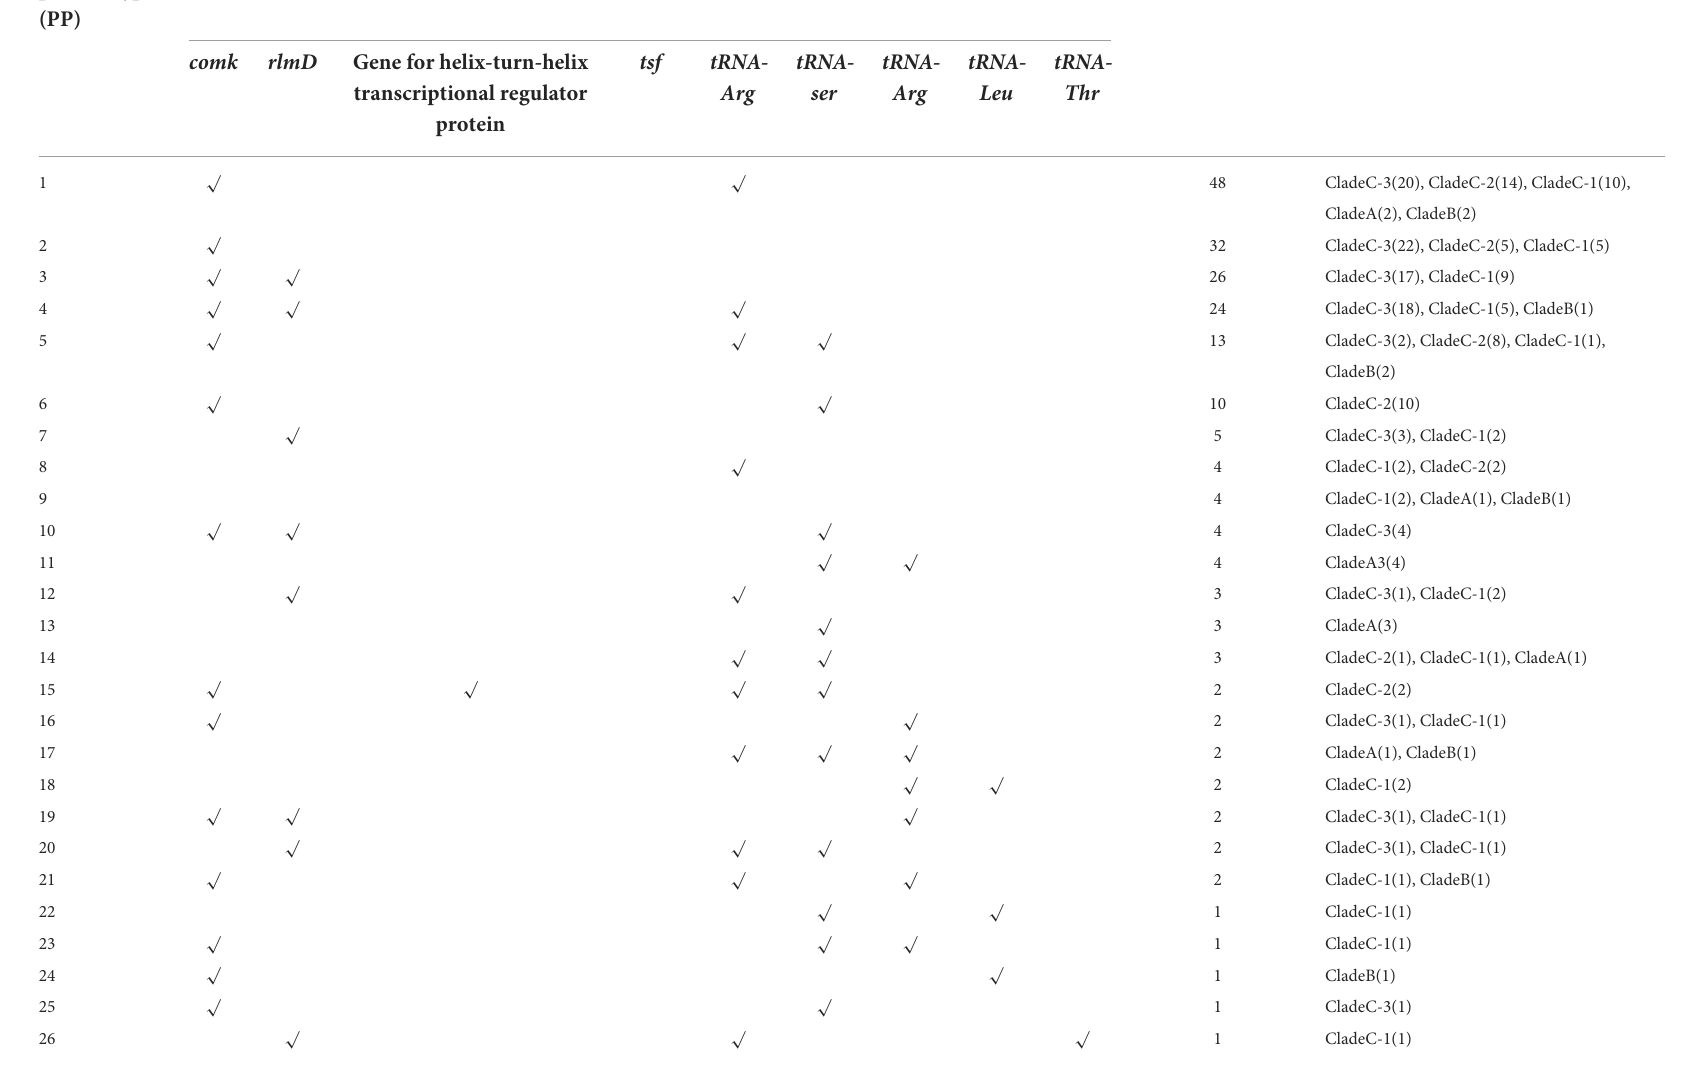
TABLE 1 The profiles of prophage insertion sites in 207 isolates of ST9 L. monocytogenes . Prophage profiles